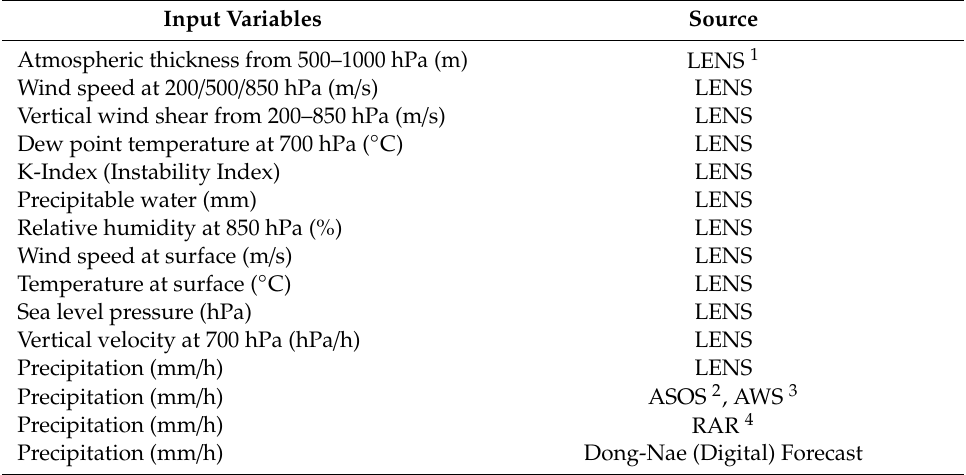
Table 2. Predictor variables used machine